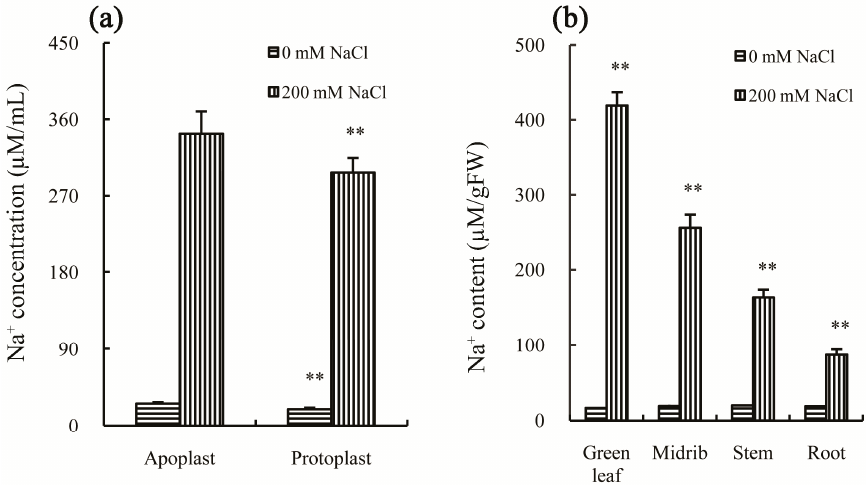
Figure 2. Effects of 200 mM NaCl stress on: the Na + concentration in the apoplast and protoplast ( a ); and the Na + content in green leaves, midribs, stems and roots ( b ). All parameters were measured on the Day 30 after salt treatment. The values are the means ( ± SD) of five replicates. ** Indicate p < 0.01.